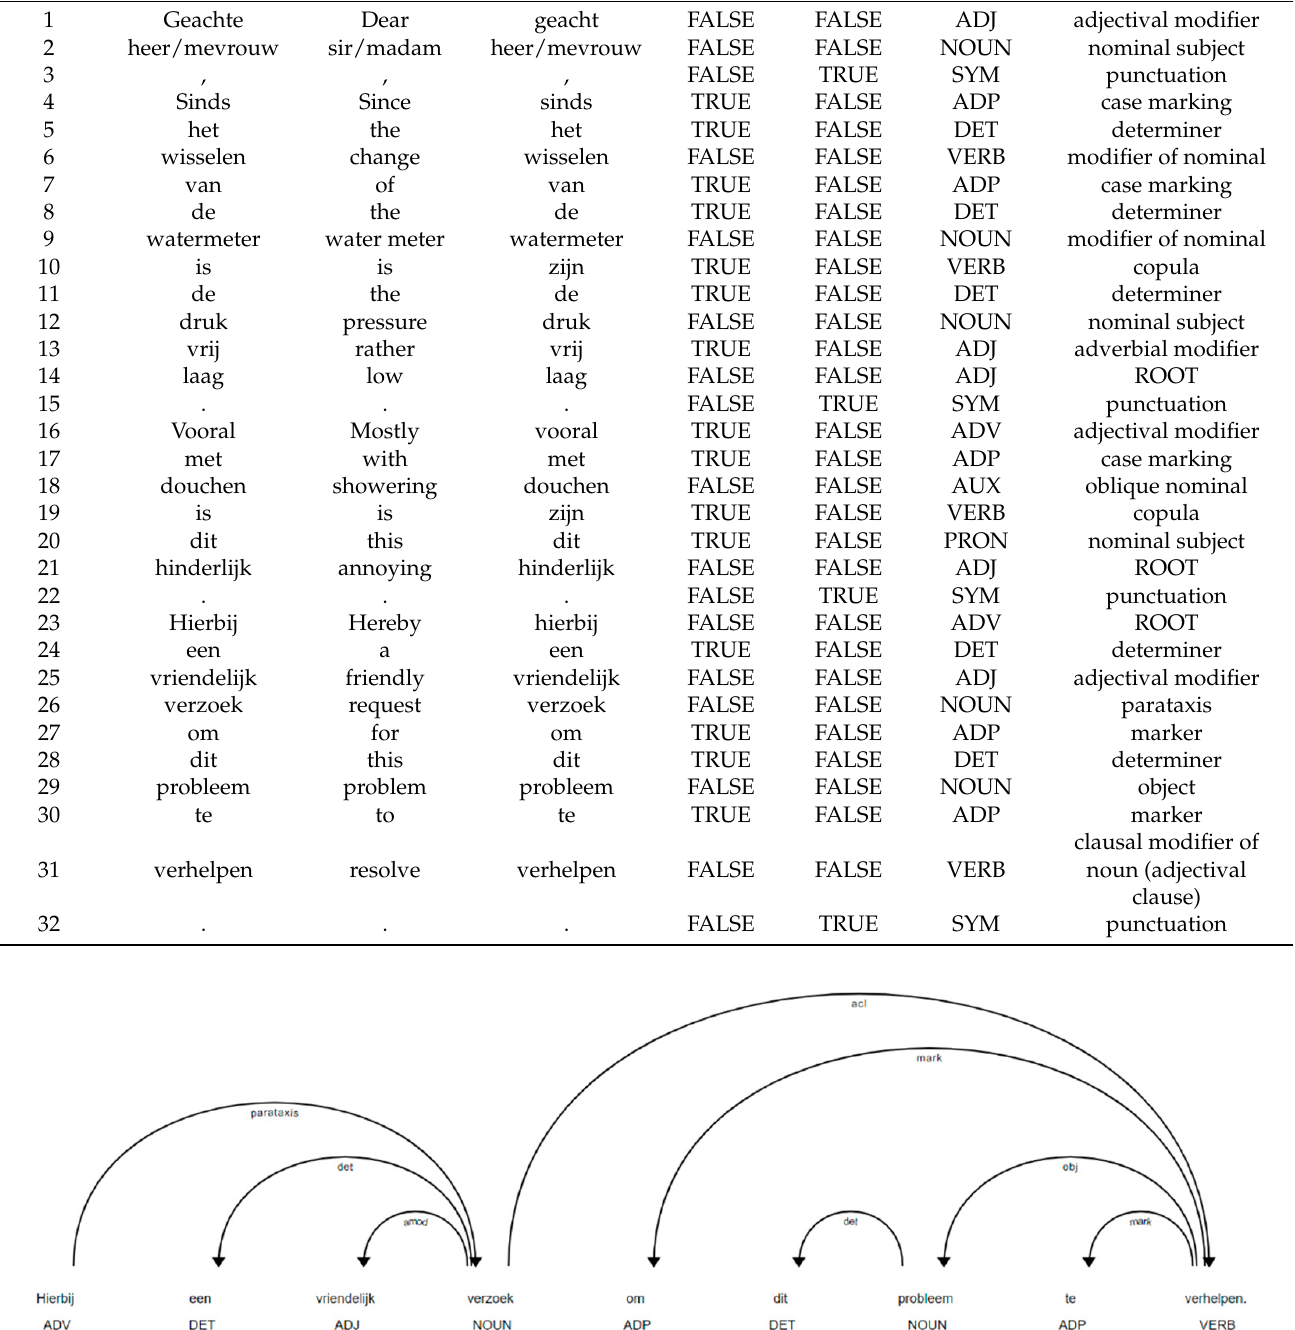
Figure 4. A dependency tree of a customer complaint, where the customer kindly requested the water utility WBG to resolve their issue of low water pressure. The dependency tree depicts the grammatical relationship between words in the sentence. English translation of this sentence: “Hereby a friendly request to solve this problem”.